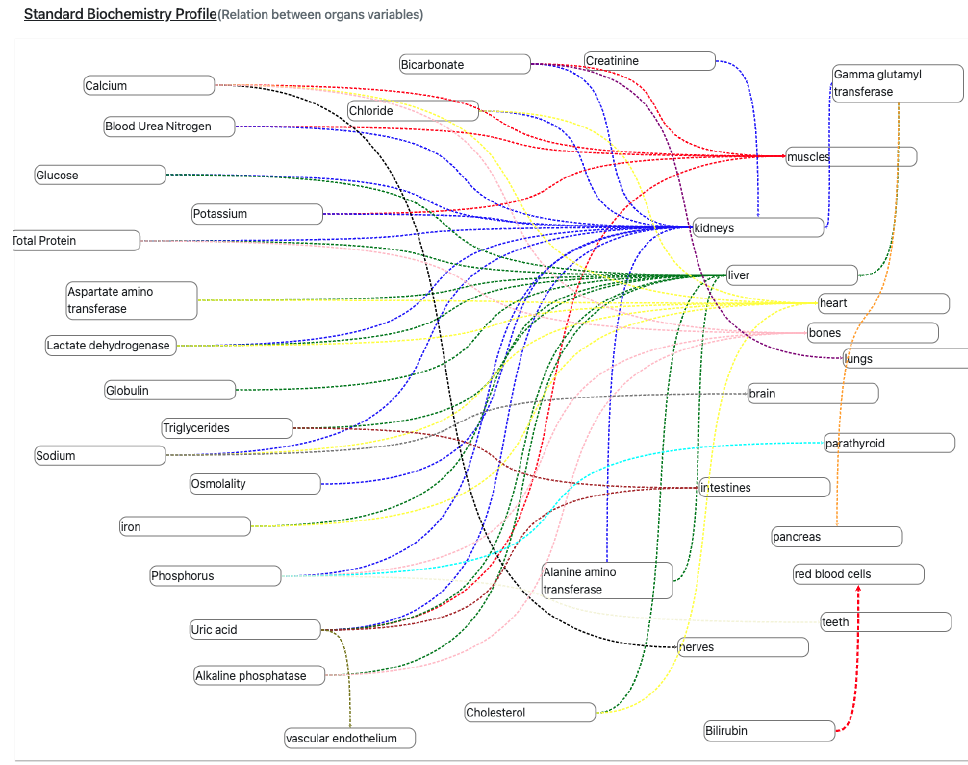
Figure 10. Blood, diet and organ functionality (screenshot from NUHealthSoft